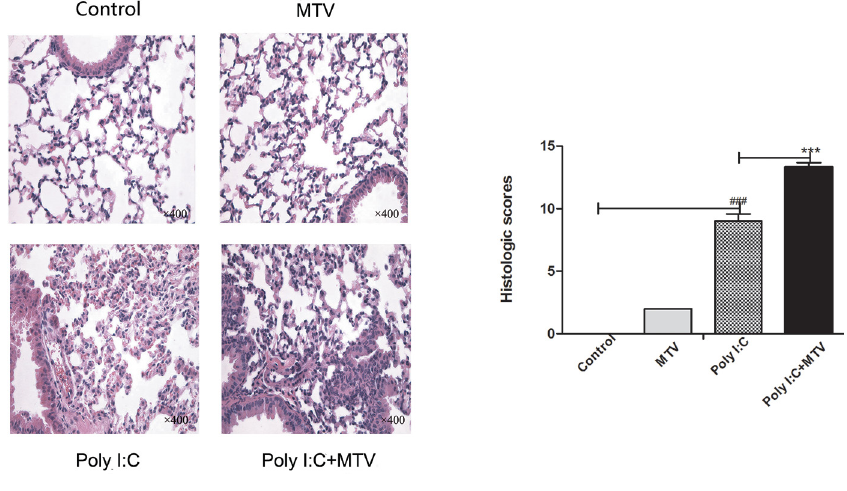
Figure 2. Morphologic alterations of the lungs as determined by photomicro- graphy. Control: photomicrograph of a pulmonary section from a control mouse. MTV: photomicrograph of a lung section from a normal mouse treated with